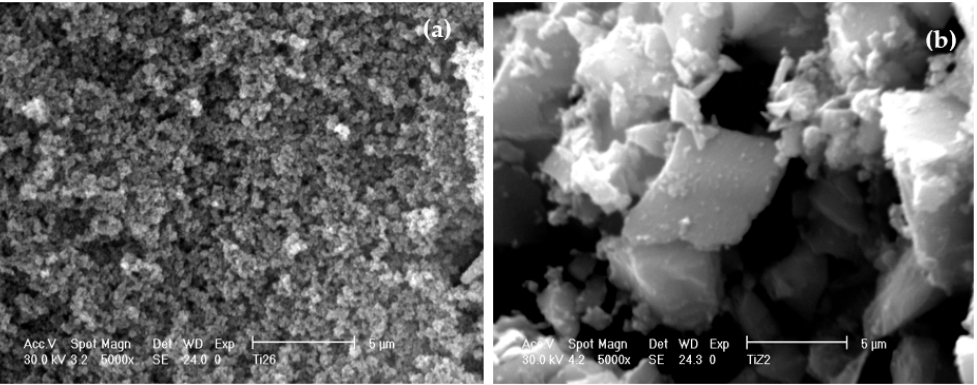
Figure 17. SEM micrographs of the sample hydrolysed at r.t. for 1 h with 0.07 M NH 4 OH, peptized for 1h with 0.05 M HNO 3 , dried by lyophilization ( a ) or at 60 °C ( b ) and calcined for 2 h at 450 °C.